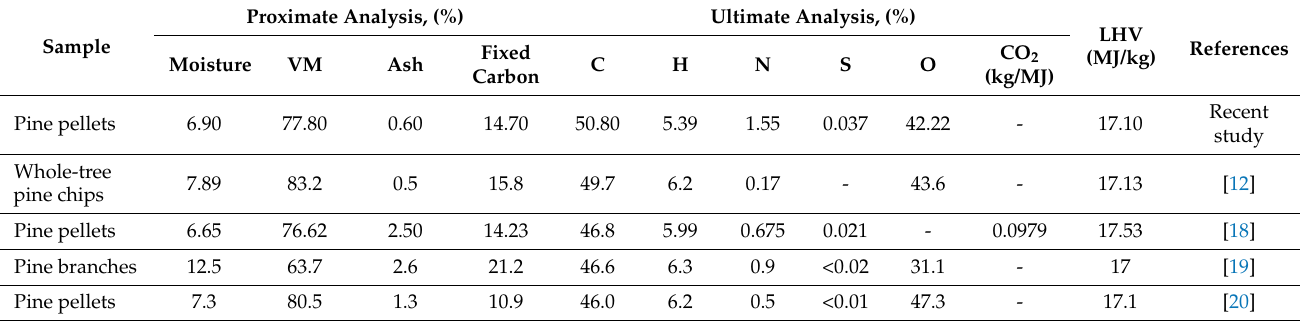
Table 1. Proximate and ultimate analysis of several